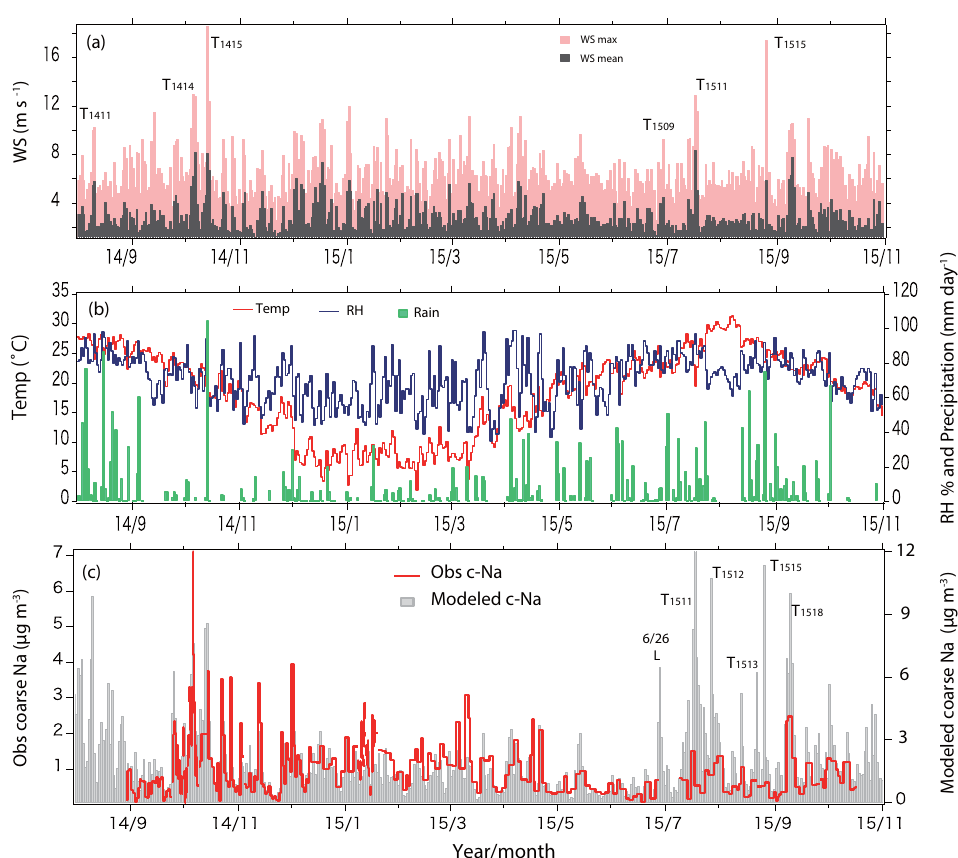
Figure 2. (a) Wind speeds (daily mean and maximum) at Fukuoka. (b) Daily average temperature, relative humidity (RH) and precipitation. (c) Observed coarse Na + and modeled coarse Na + (converted from GEOS-Chem coarse sea salt). T indicates typhoons: T1411 is Halong, T1414 is Fengshen, T1415 is Kalmaegi, T1509 is Chanhom, T1511 is Nangka, T1512 is Halola, T1513 is Soudelor, T1515 is Goni, and T1518 is Etau. Table 1. Statistical summary of comparisons of the model results with observations between August 2014 and October 2015. Mean Mean Normalized mean Mean fractional Mean fractional Concentration observation model bias